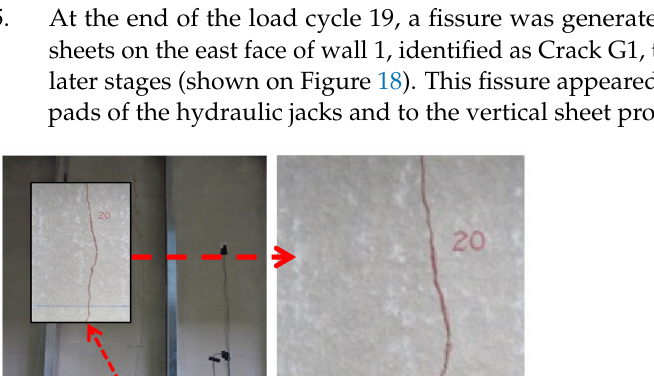
Figure 17. Elevation registered on wall 1.